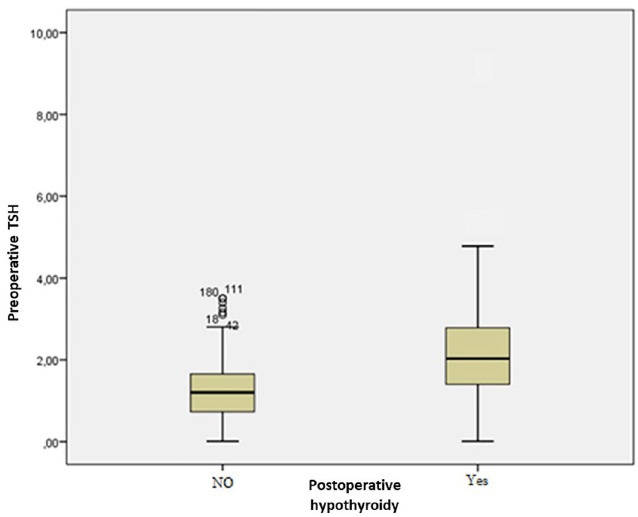
Figure 1. Distribution of patients according to preoperative thyroid stimulating hormone (TSH)